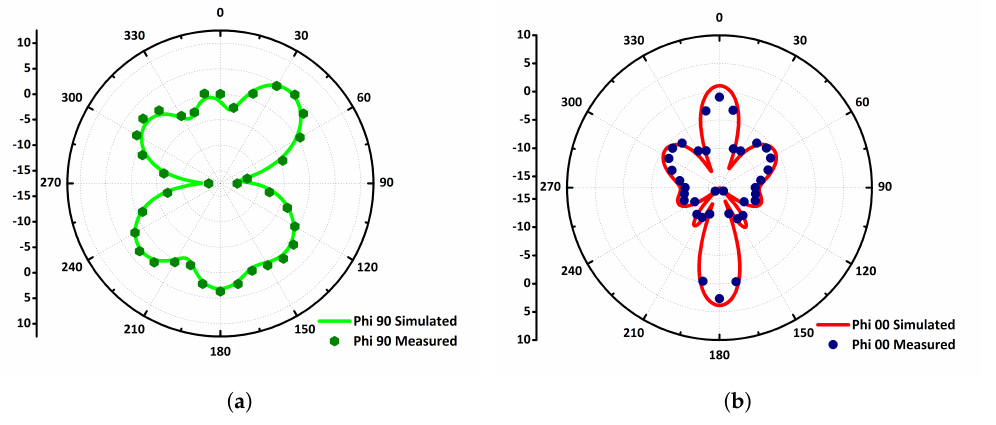
Figure 9. Radiation patterns: ( a ) Phi = 90; and ( b ) Phi =